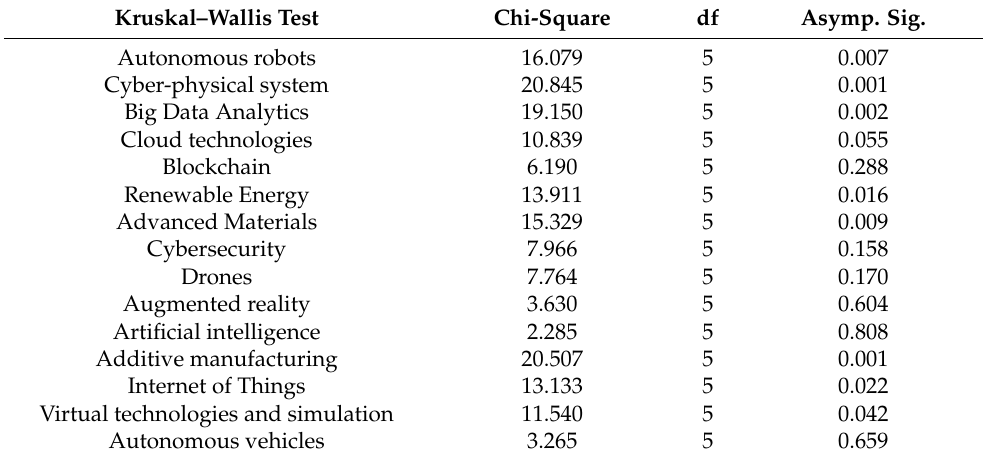
Table 10. Evaluation of null and alternative research